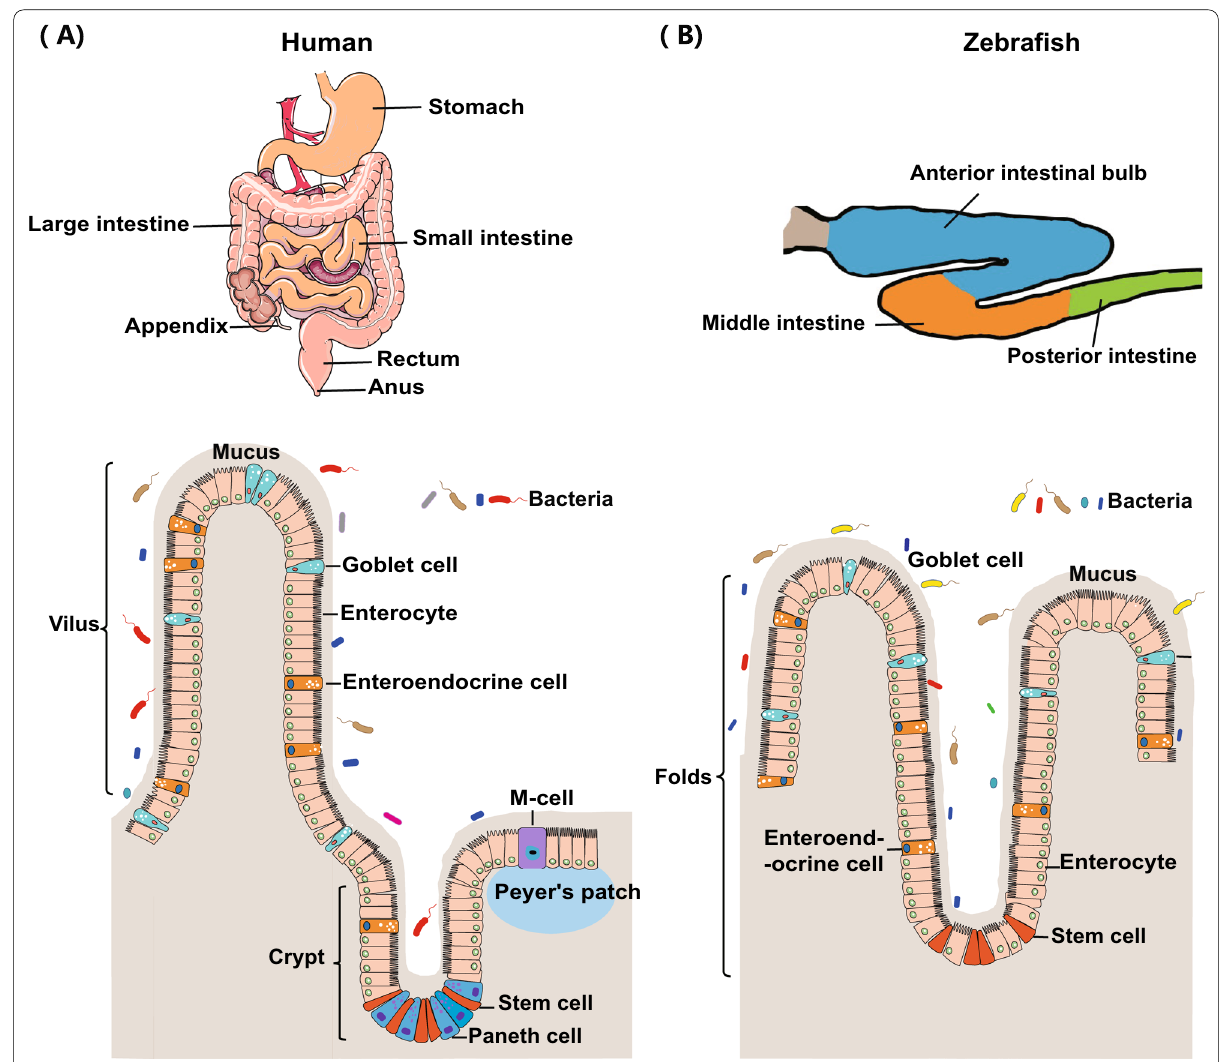
Fig. 1 Abdominal anatomy of intestinal tracts between humans A and adult zebrafish ( B ). Epithelial cells are specified as either secretory or enterocytes as they migrate up the villi in mammals or folds in zebrafish. The mature zebrafish intestine has three segments: anterior intestinal bulb (blue), middle intestine (orange), and posterior intestine (green). Mature epithelial cells include enterocyte, enteroendocrine, and goblet cells. Compared with the human intestine, crypts, Paneth cells, and M-cells are absent in the zebrafish